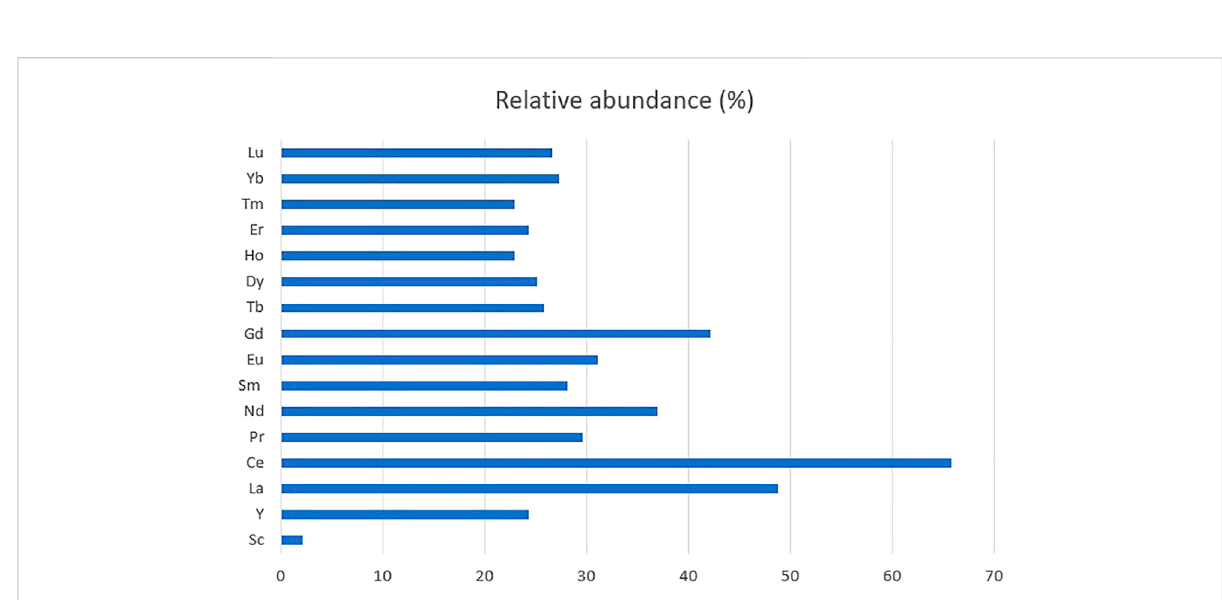
FIGURE 3 Comparison of the relative abundance (%) of papers including information for the toxicity of each REE to human